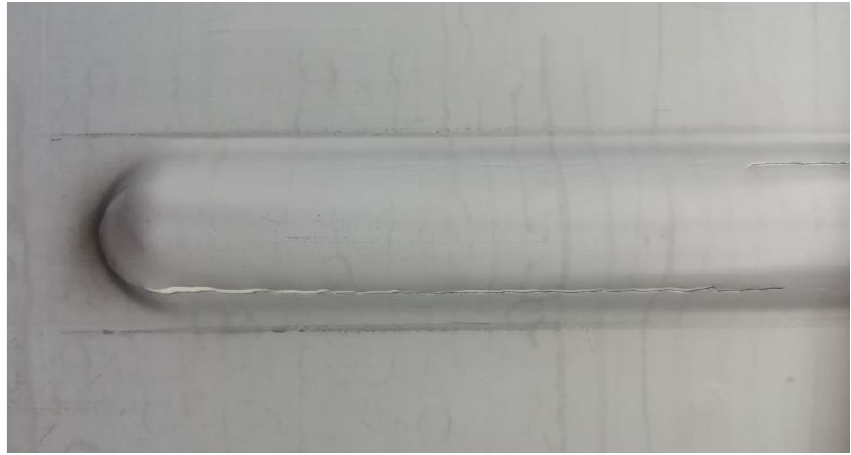
Figure 6. Tearing of the Litecor ® ribs surface during case C: f = 1500 mm/min, n = 300 rpm.